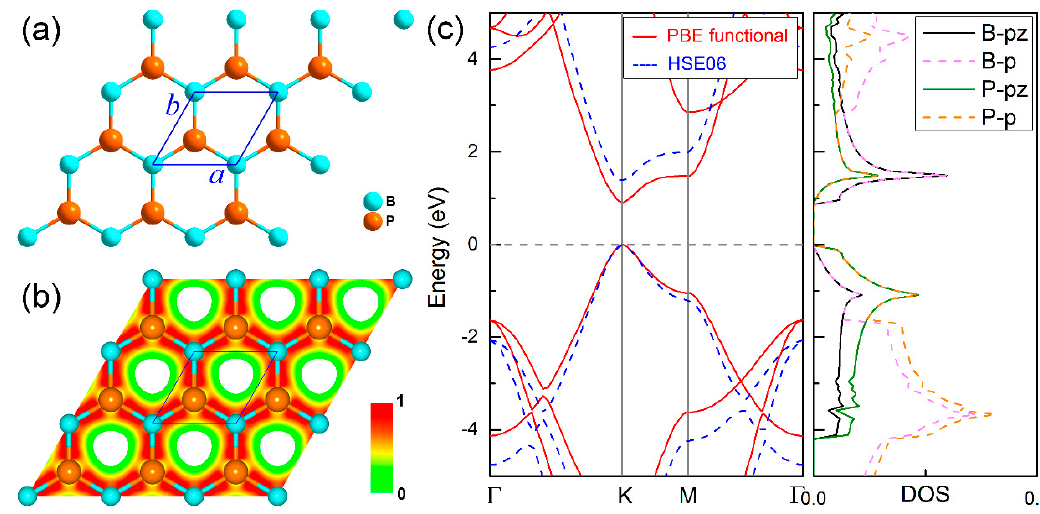
Figure 1. ( a ) Fully optimized structure, ( b ) charge density, and ( c ) electronic band structures obtained using PBE and HSE06 functionals and density of state (DOS) for boron-phosphide monolayer. Light blue and orange balls represent B and P atoms, respectively.